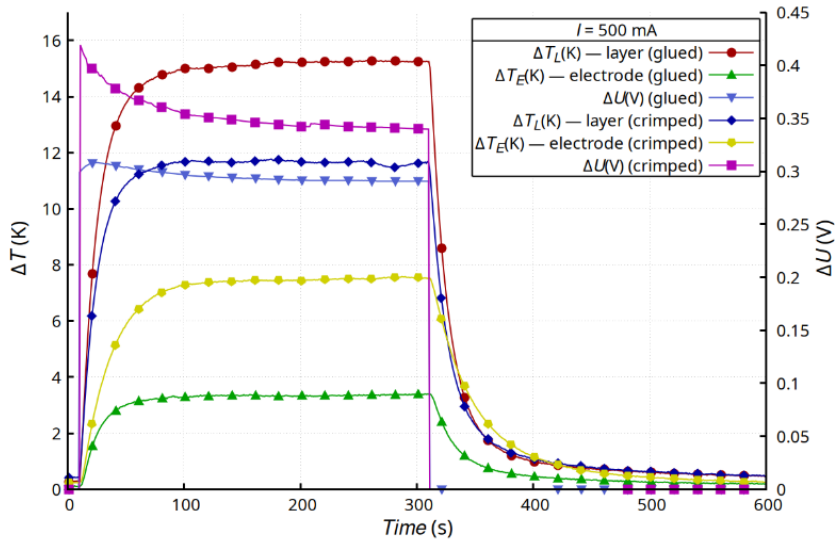
Figure 7. Comparison of results for the G + T sample and C + T sample for I = 500 mA. The initial temperature of the samples was 21 – 23 °C (as can be seen in Figure 8). This meant that the temperature after heating the sample with Joule ’ s heat ranged from 23 to about 40 °C depending on the value of the flowing current (100 – 700 mA). The selection of the temperature range was not accidental and correlated with the typical differences be- tween the temperature of the human body and the ambient temperature. The temperature